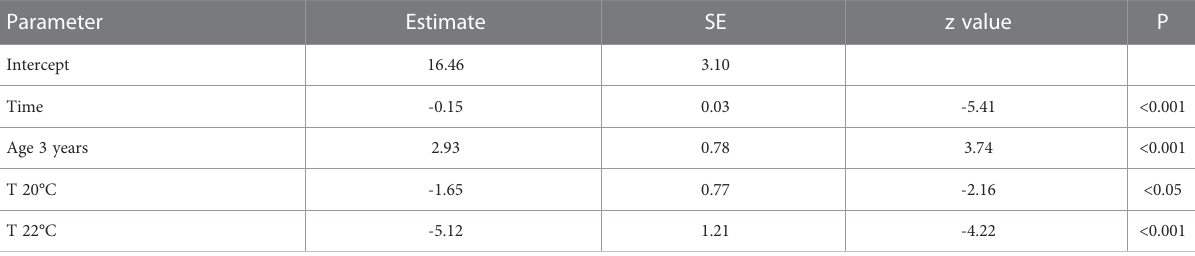
TABLE 5 Summary table for generalized linear mixed effects model of the effect of duration after hatch (time), maternal age (1 and 3 years), and temperature (18, 20, and 22°C) on survival rate during starvation of chub mackerel larvae.